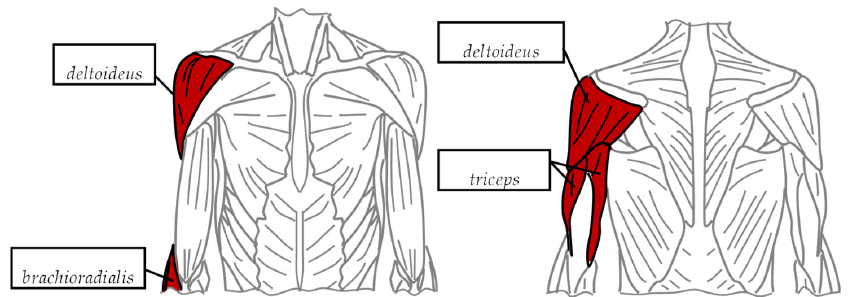
Figure 8. Analyzed Figure 8. Analyzed muscles. Figure 8. Analyzed muscles.